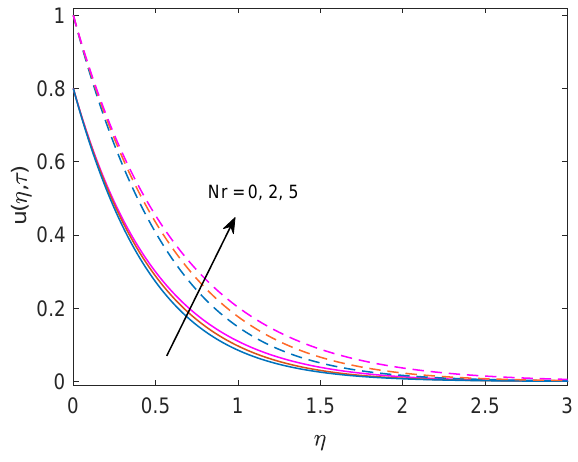
Figure 8. Effect of different values of Nr.